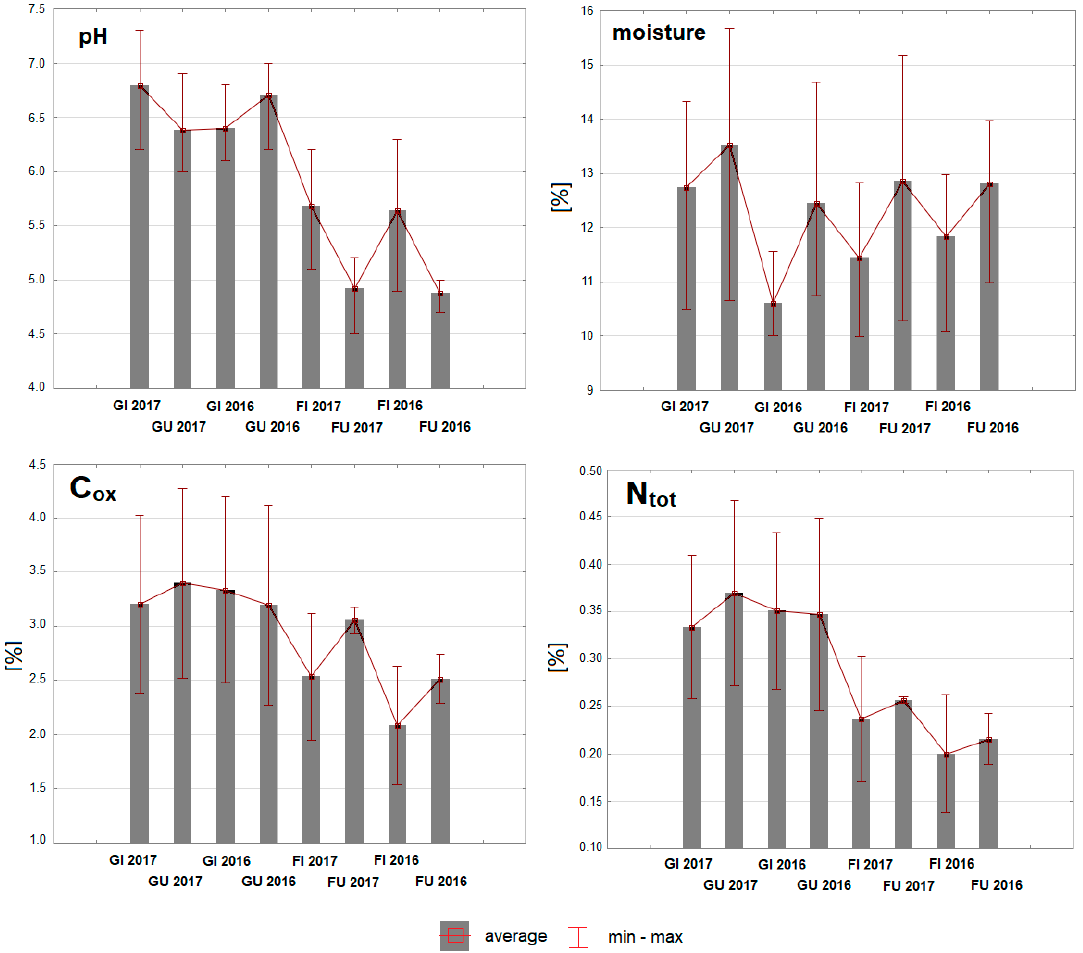
Figure 2. Soil physicochemical properties in two ecosystems (forest and grassland) under invaded and uninvaded sites in 2016 and 2017 (pH (in 0.01M CaCl 2 ), moisture (soil moisture %), C ox (soil organic carbon %), N tot (total nitrogen %), FI (forest invaded ecosystem), FU (forest uninvaded ecosystem), GI (grassland invaded ecosystem), GU (grassland uninvaded ecosystem). Table 2. The values of Mann–Whitney nonparametrical test for comparison soil characteristics between ecosystems (grassland and forest) regardless of the year and the invasion status (invaded, noninvaded sites).